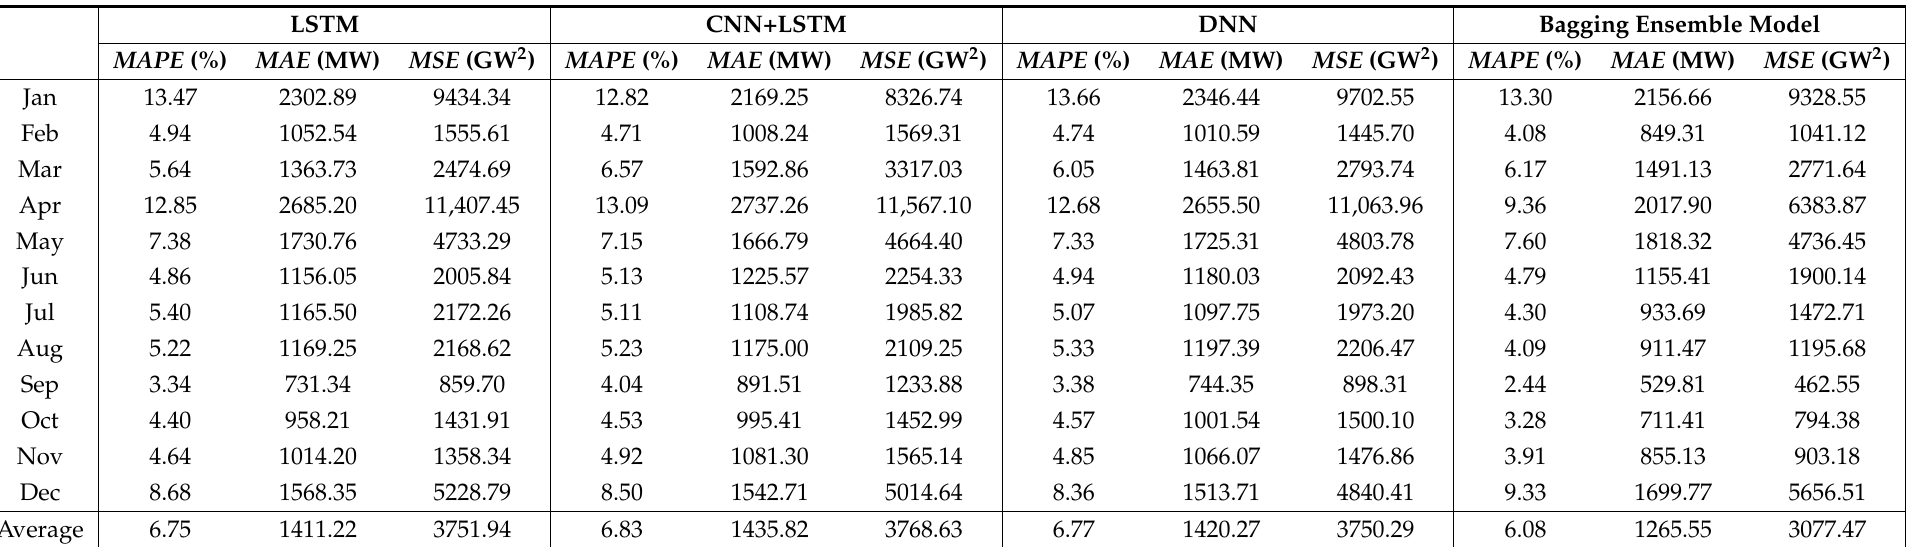
Table 3. Error Measurements of Test Data for Six Input Features in